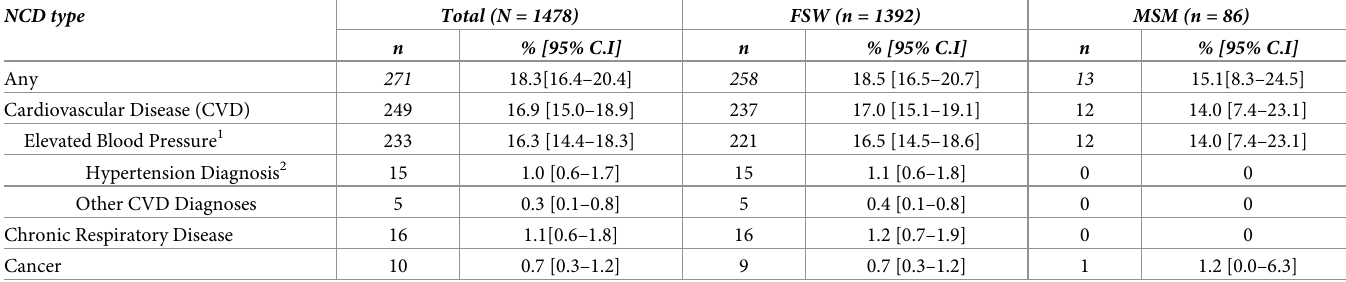
Table 3. Prevalence of Non-Communicable Diseases (NCDs) among key populations living with HIV at SWOP clinics in Nairobi, Kenya, 2012–15. NCD